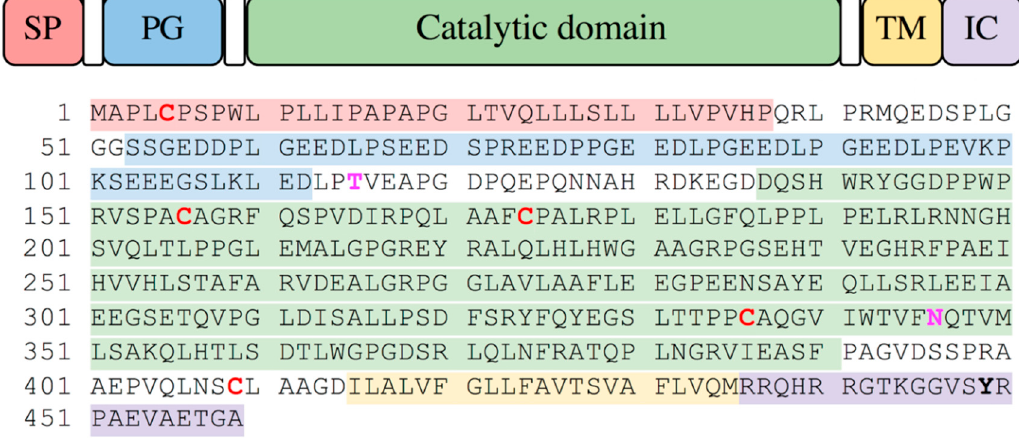
Figure 1. Sequence of native, full length human CA IX. The domains are shown in the image and mapped onto the sequence below using the same colors. Cys residues are shown in red and bold, glycosylated residues are shown in magenta, and phosphorylated residue in bold.